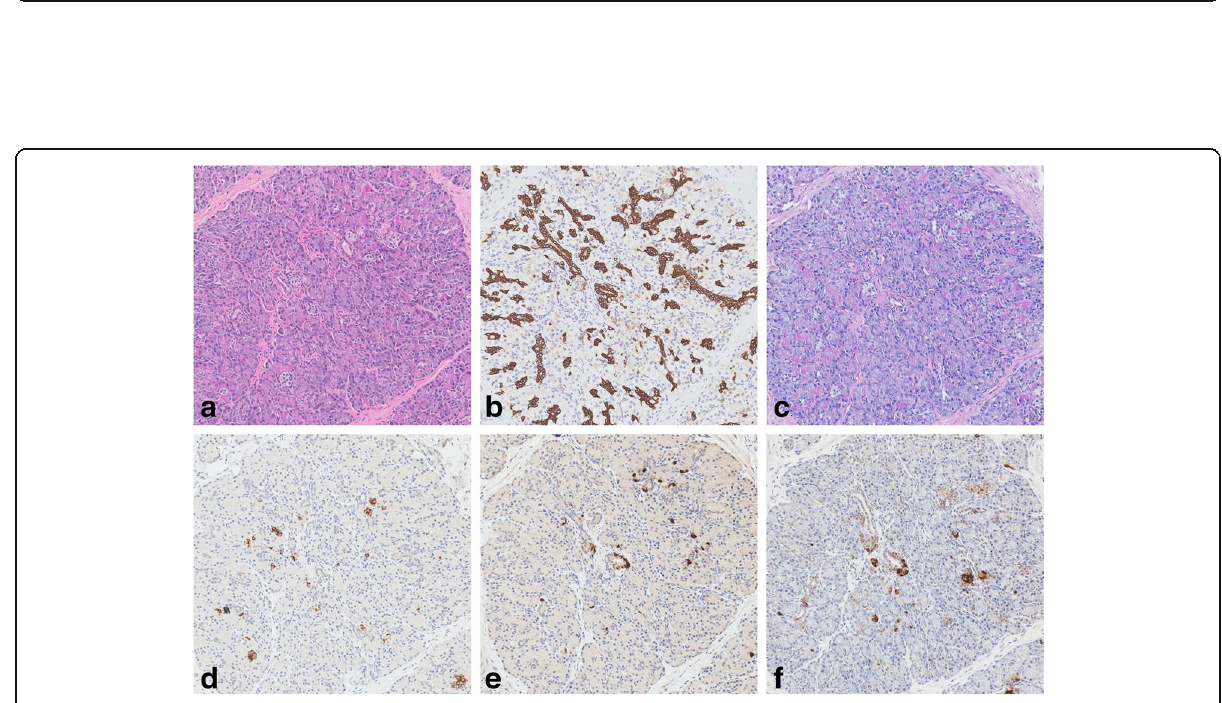
Fig. 5 Heterotopic pancreatic components. The haematoxylin and eosin micrograph showed exocrine and endocrine structures of pancreas ( a , original magnification ×10). Ducts and pancreatic acini were highlighted by pan-cytokeratin marker AE1/3 immunostaining ( b , ×10) and Periodic acid – Schiff – diastase special stain ( c , ×10) respectively. The distribution of insulin-, glucagon-, and somatostatin-producing neuroendocrine cells scattered in the islets were demonstrated with respective immunohistochemistry ( d to f ,